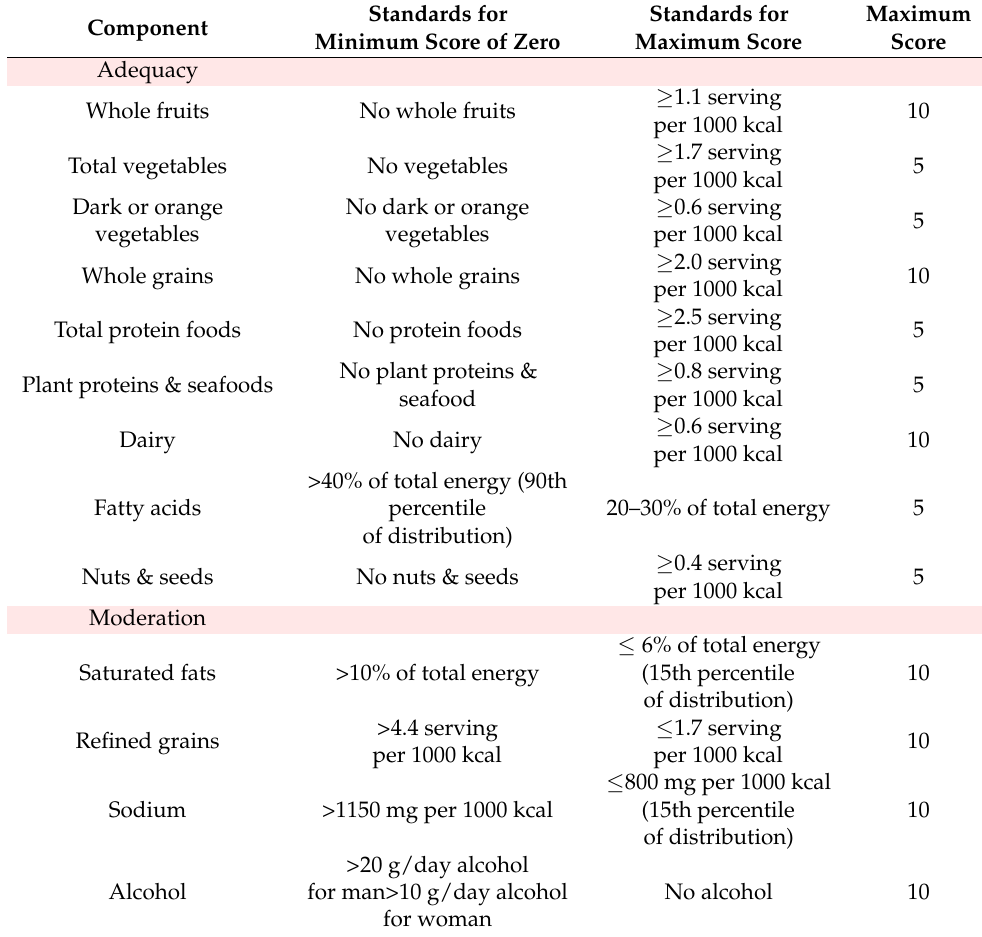
Table 1. Taiwanese Healthy Eating Index (T-HEI) components and standards for